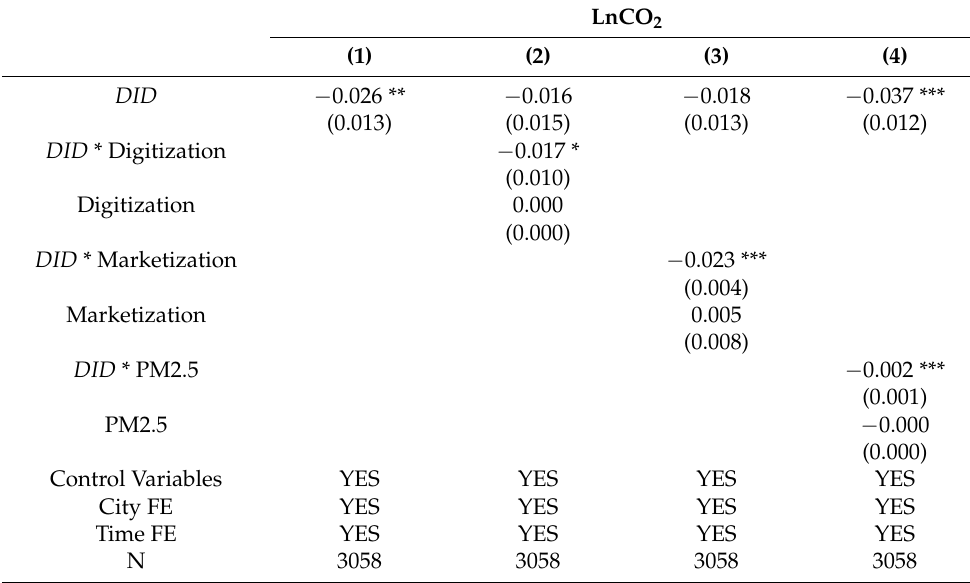
Table 14. Synergy Effect